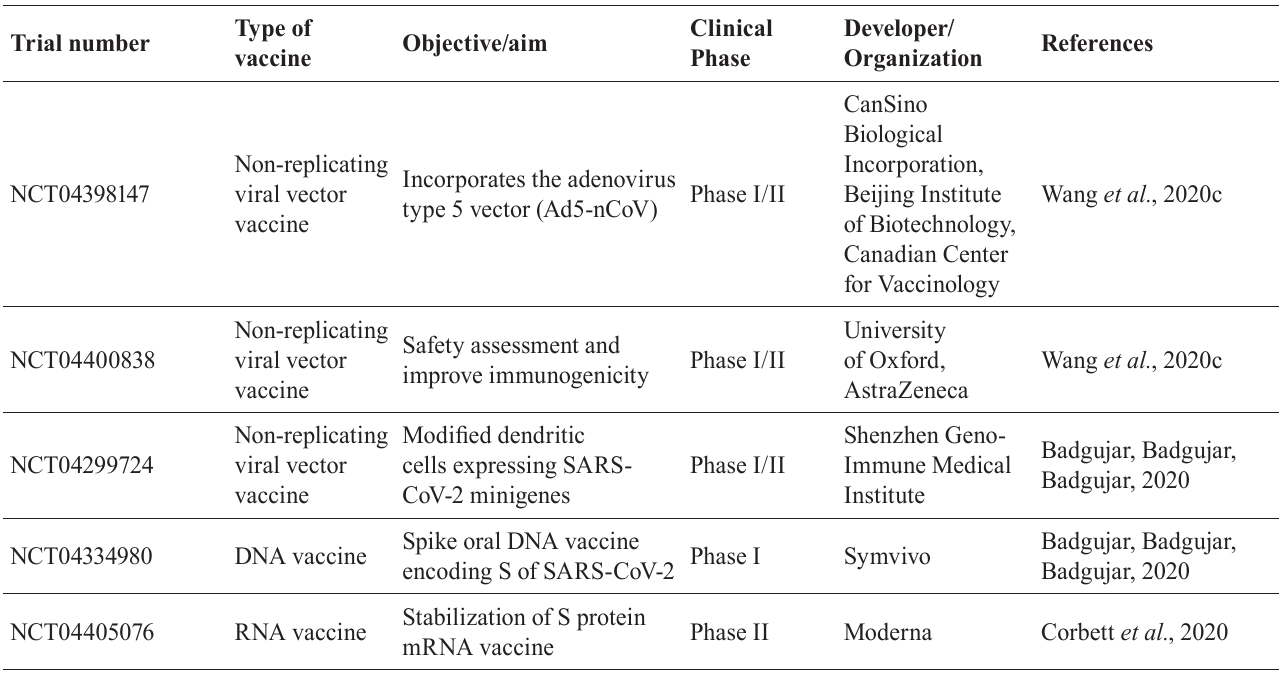
TABLE II - Coronavirus vaccines which are under clinical trials